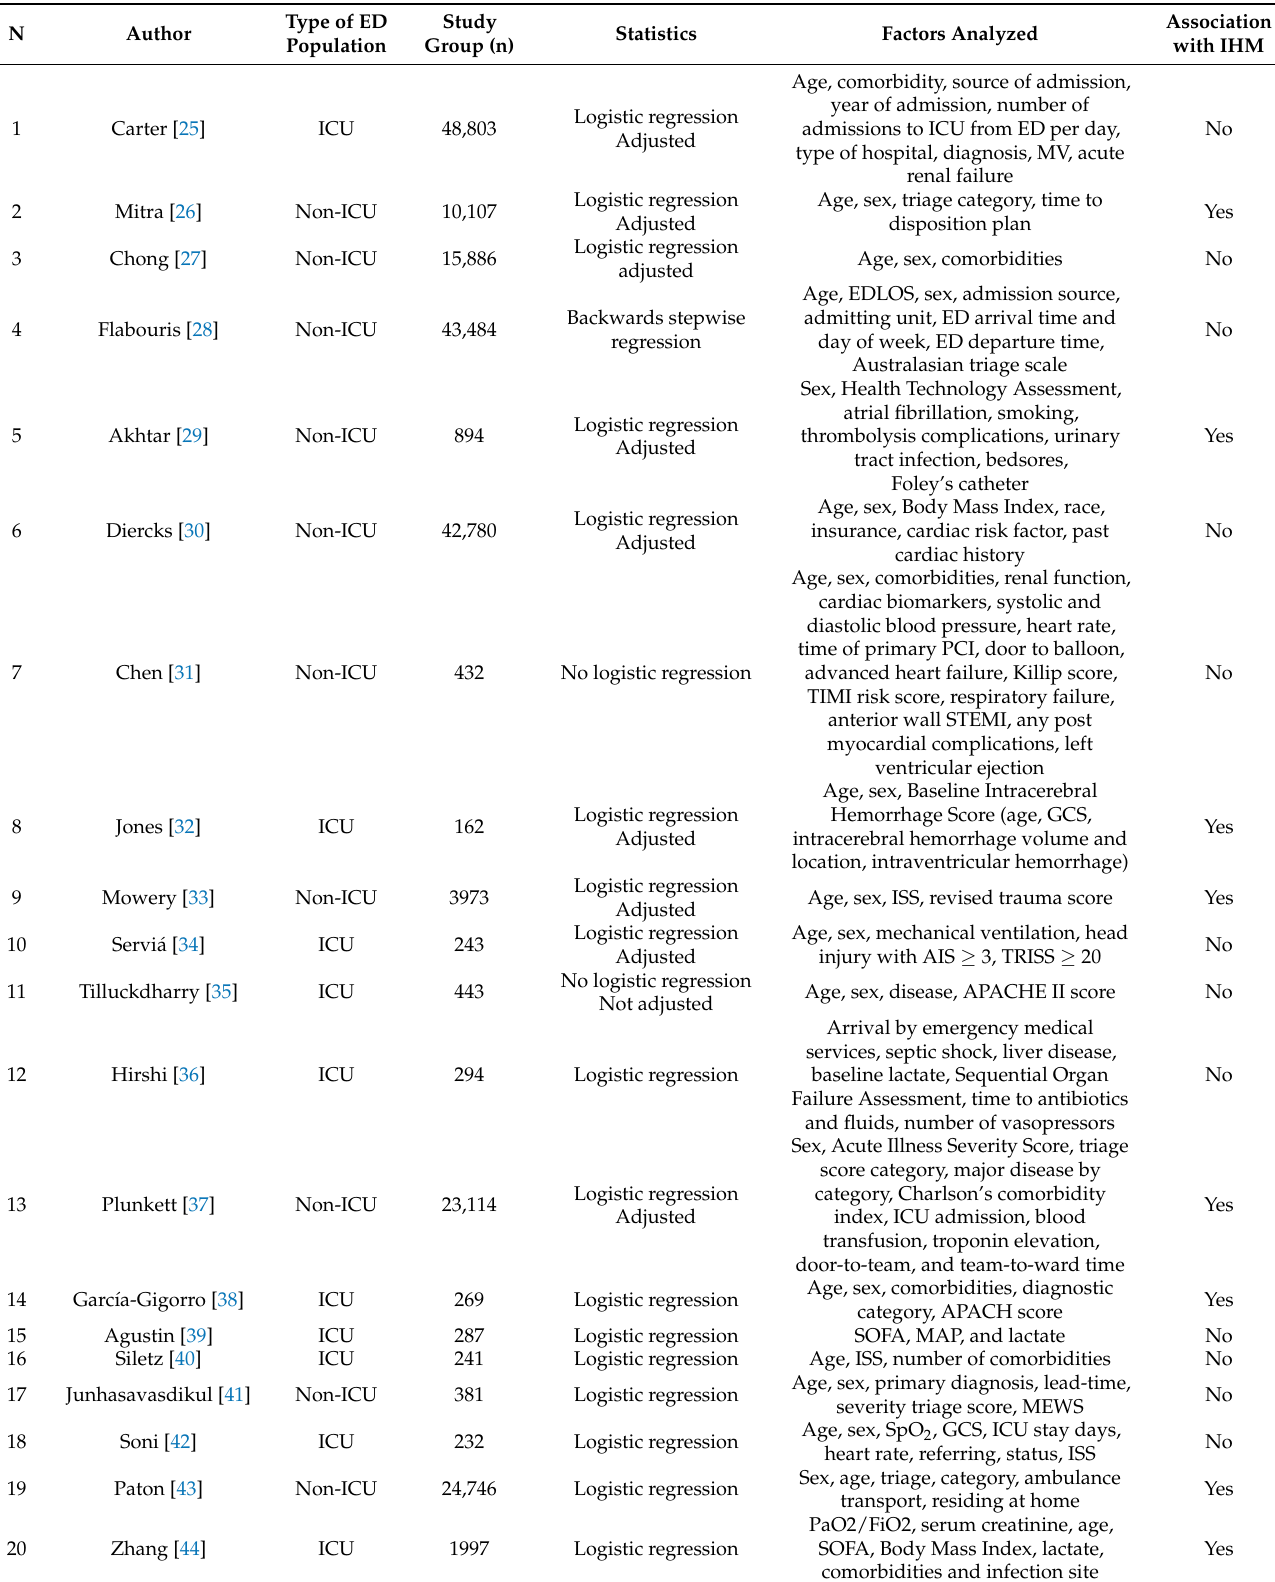
Table 2. Factors analyzed and association between EDLOS and in-hospital mortality in the selected studies for the systematic